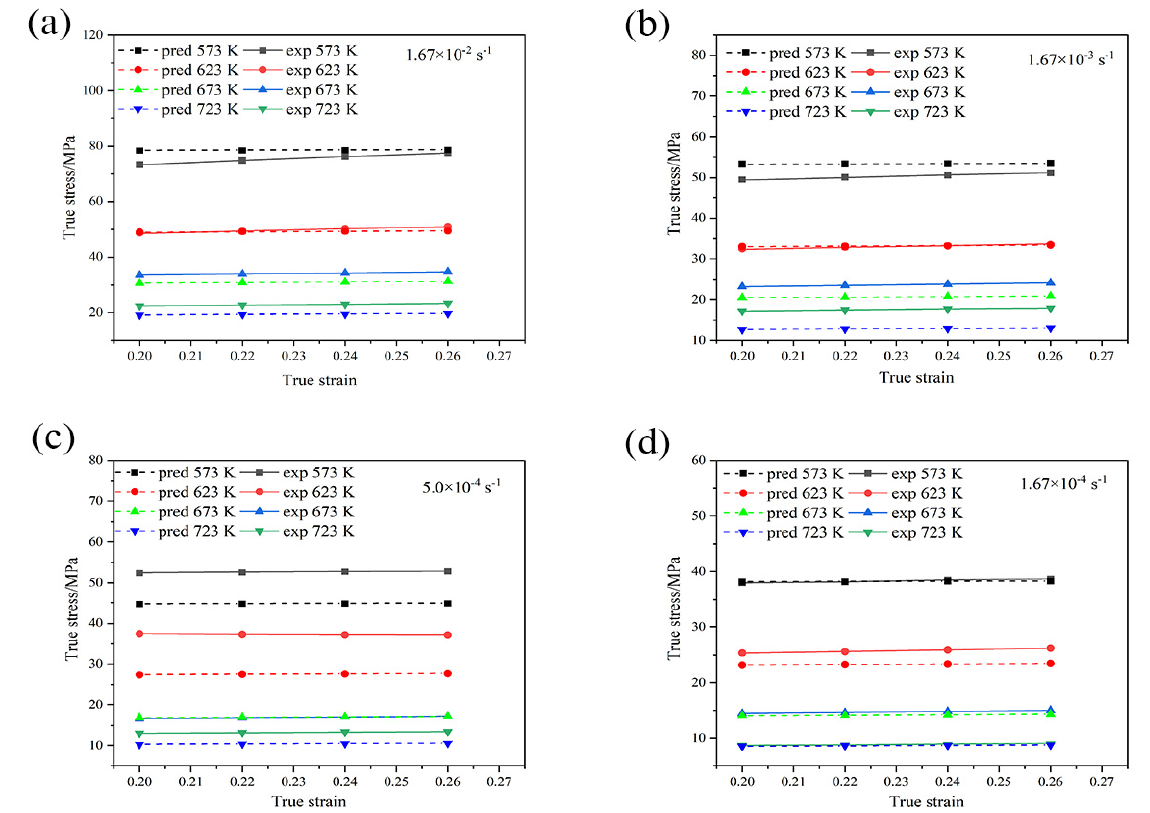
To validate Equation (9), true stress versus true strain curves with measured values and calculated values are plotted, as shown in Figure 12.